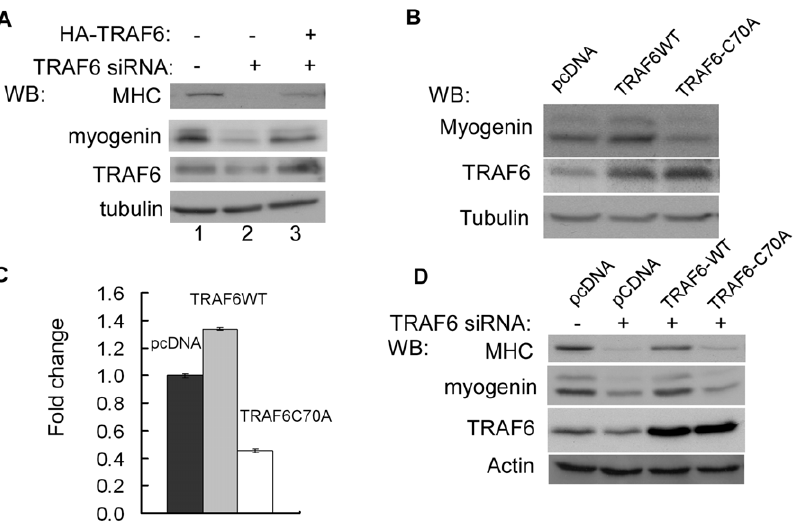
Figure 2. The E3 ligase activity of TRAF6 was required for myogenic differentiation. (A) C2C12 cells were transfected with either the GFP- siRNA or the TRAF6-siRNA together with an empty vector or a vector encoding human TRAF6 as indicated. (B) C2C12 cells were transfected with either an empty vector (pcDNA) or an expression vector encoding either the wild-type (WT) or an E3 ligase-defective mutant TRAF6. (C) C2C12 cells were transfected in triplicate with G133- luc together with pcDNA or an expression vector encoding the wild-type or the mutant human TRAF6. Twenty-four hours after transfection, cells were switched to DM for another 24 hours. WCEs were prepared and subjected to luciferase assays. Fold change was calculated as the ratio of the luciferase activity in TRAF6-transfected cells over that in pcDNA-transfected cells. The results were presented as mean + s.d. (D) C2C12 cells were transfected with the GFP-siRNA or TRAF6-siRNA together with pcDNA or an expression vector encoding the wild type or mutant human TRAF6. For (A), (B), and (D), cells were harvested at DM 36 h and WCE were subjected to SDS-PAGE and Western blot analysis for various proteins as indicated.